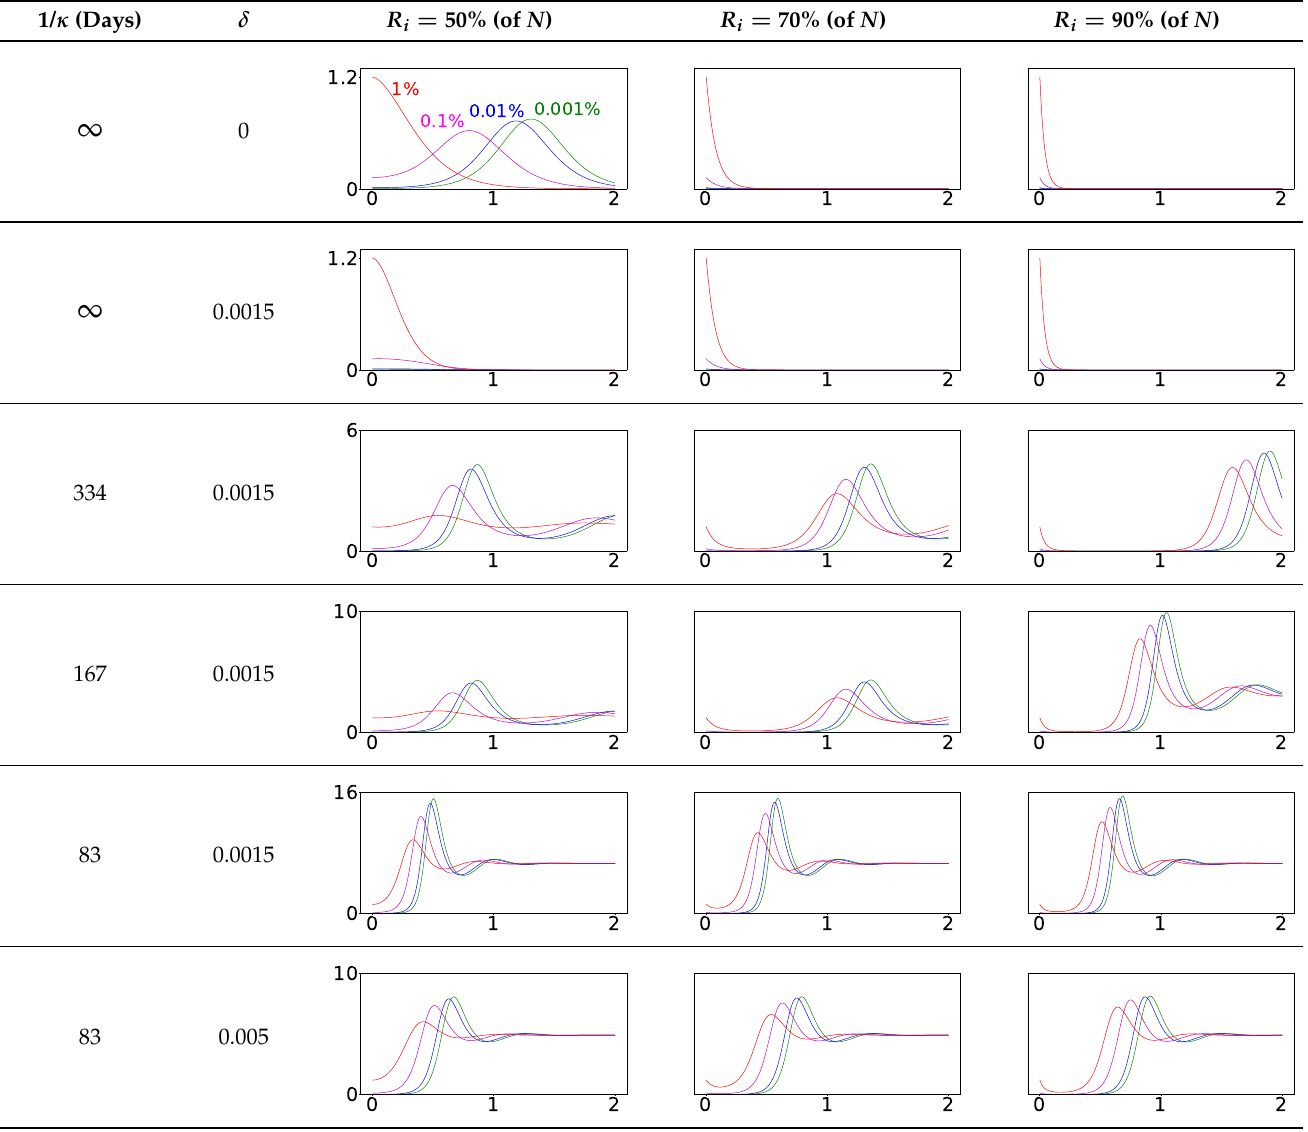
Table 1. Time evolution of infected ( I + A ) following disease